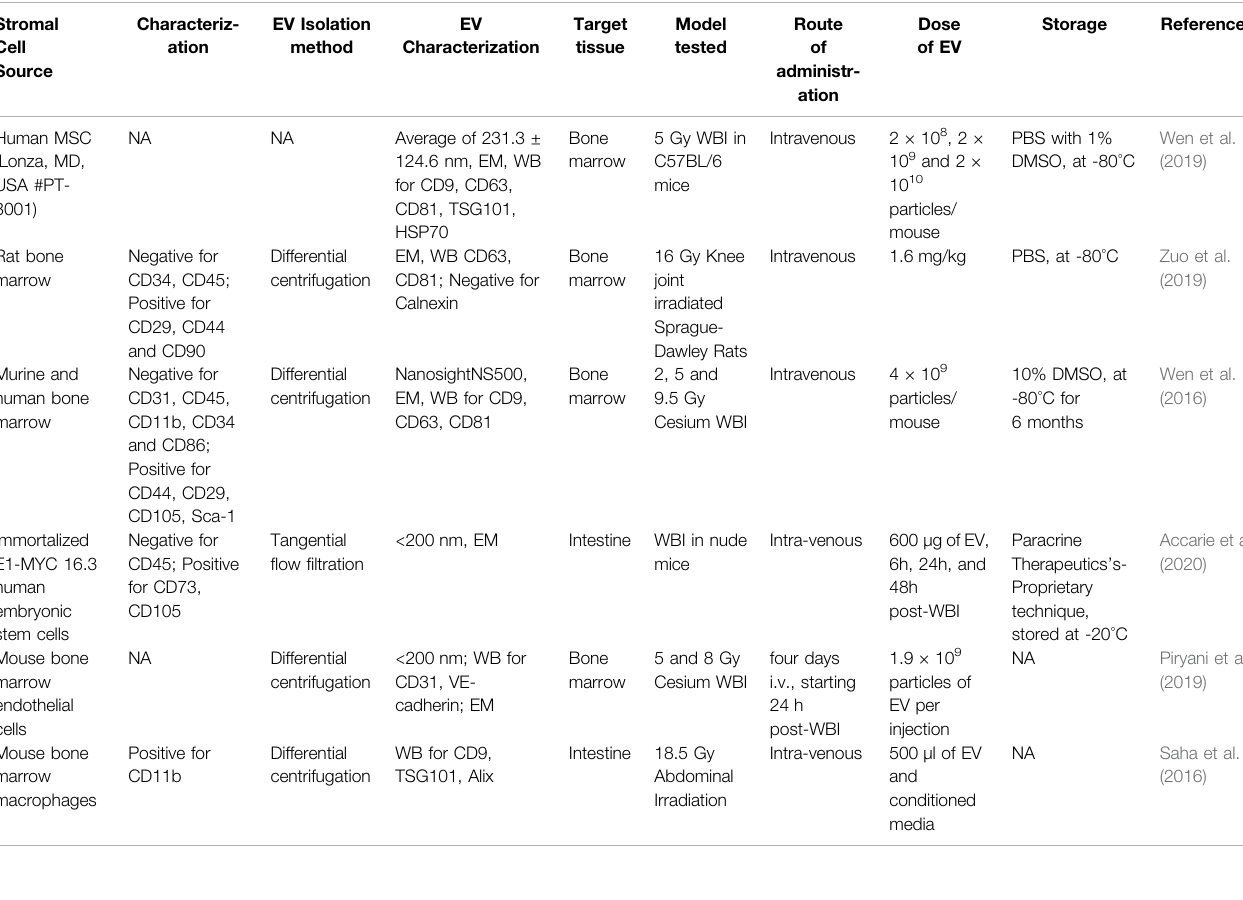
TABLE 4 | Application of BMMSC-, EC- and macrophage-EVs for organ repair in radiation injury models. Stromal Cell